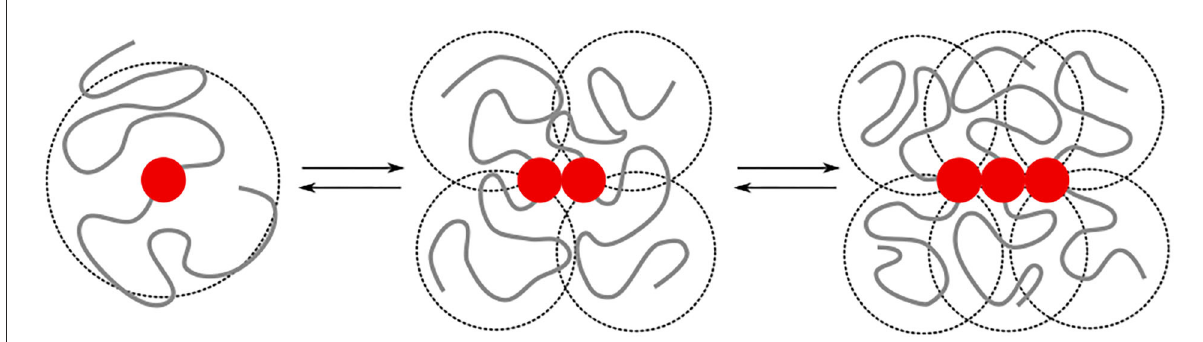
FIGURE1 We model the growth of an oligomer through reversible bonds between bivalent stickers (red bead). The cooperativity is controlled by a difference in the binding energy for dimerisation/nucleation ( ε n ) and elongation ( ε e ). The total binding energy is further affected by repulsive excluded volume interactions between beads, as well as attractive hydrophobic interactions ( ε H ) between beads within a short interaction range. The excluded volume interactions and hydrophobic interactions depend on the overlap (indicated by the dashed circles) of the intrinsically disordered sequences; the amount of overlap non-linearly increases with the length of the chains. In this study, we study how the added hydrophobic interactions and increased chain length of A β 1 compared to A β 1 affects the self-assembly into oligomers. − 42 − 40